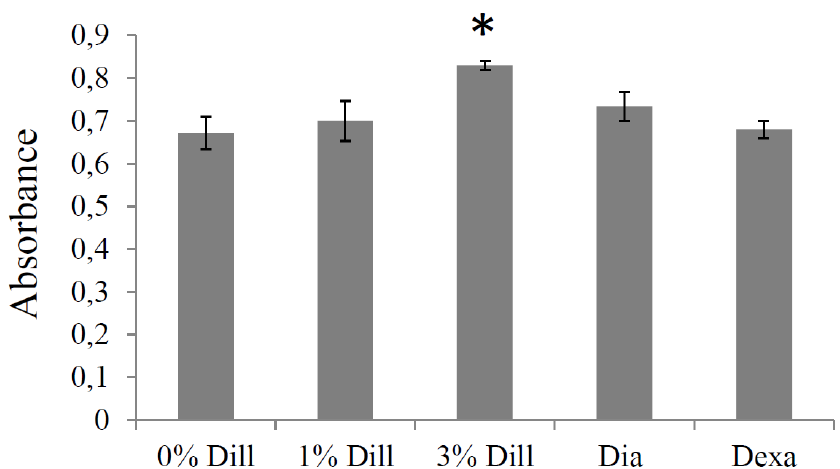
Figure 7 . Effect of DE on elastin production by cultured vascular smooth muscle cells from the ascending aorta of aged mice. The effects of dexamethasone (Dexa, 0.1 µM) and diazoxide (Dia, 50 µM) were also tested as these compounds have previously been shown to result in elastin production stimulation by cultured aortic VSMCs (see text). Dill: DE. The absorbance is representative of extracellular elastin quantity. * Significantly different from 0% DE, the negative control (one-way ANOVA, followed by LSD tests, p ≤ 0.05). n = 5–6 in each group